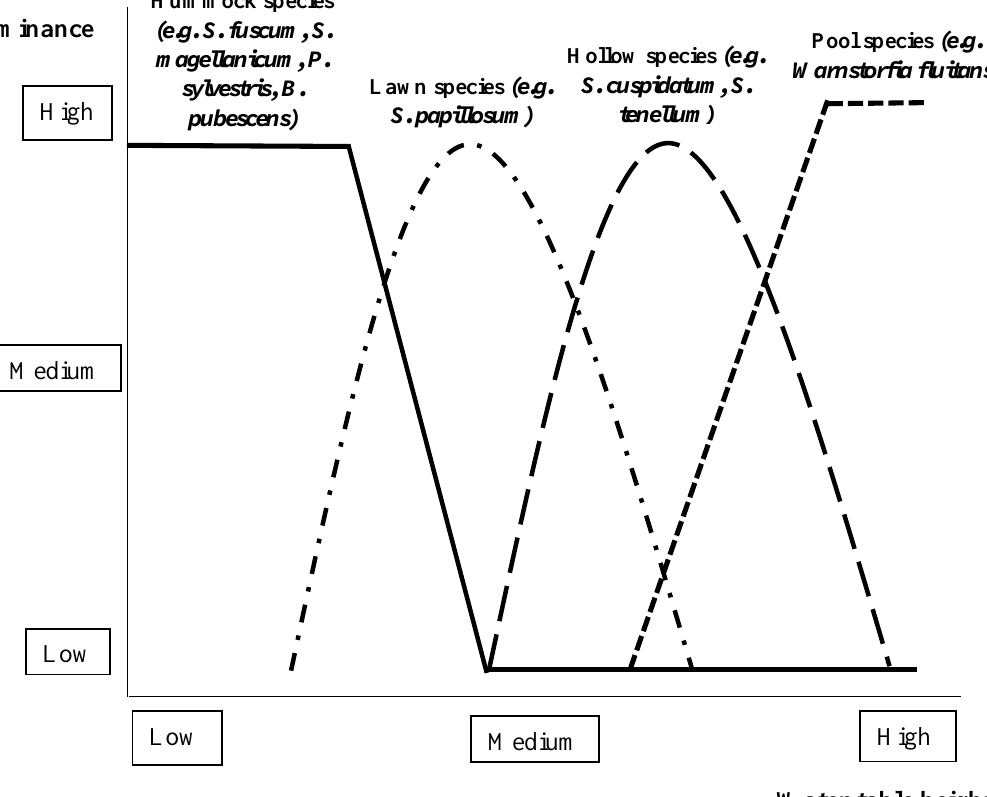
Figure 5. Examples of relationships observed in the literature reviewed between relative dominance of different foundation species and water table height (lower/higher water table height means drier/wetter conditions) in boreal and temperate peatlands (see Section 2.2.1 and refer to Belyea